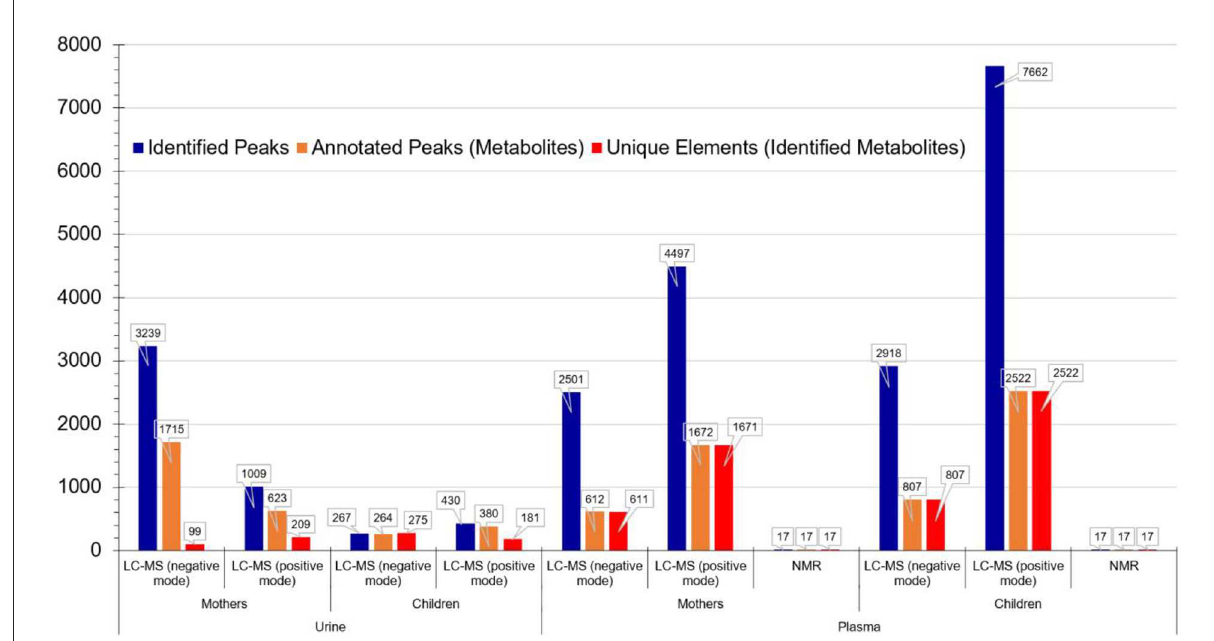
FIGURE2 Metabolomics analysis results per matrix, population group and technology for the PHIME cohort. It is evident that the use of different platforms (LC-MS and NMR) resulted in a much broader coverage of detected metabolites.